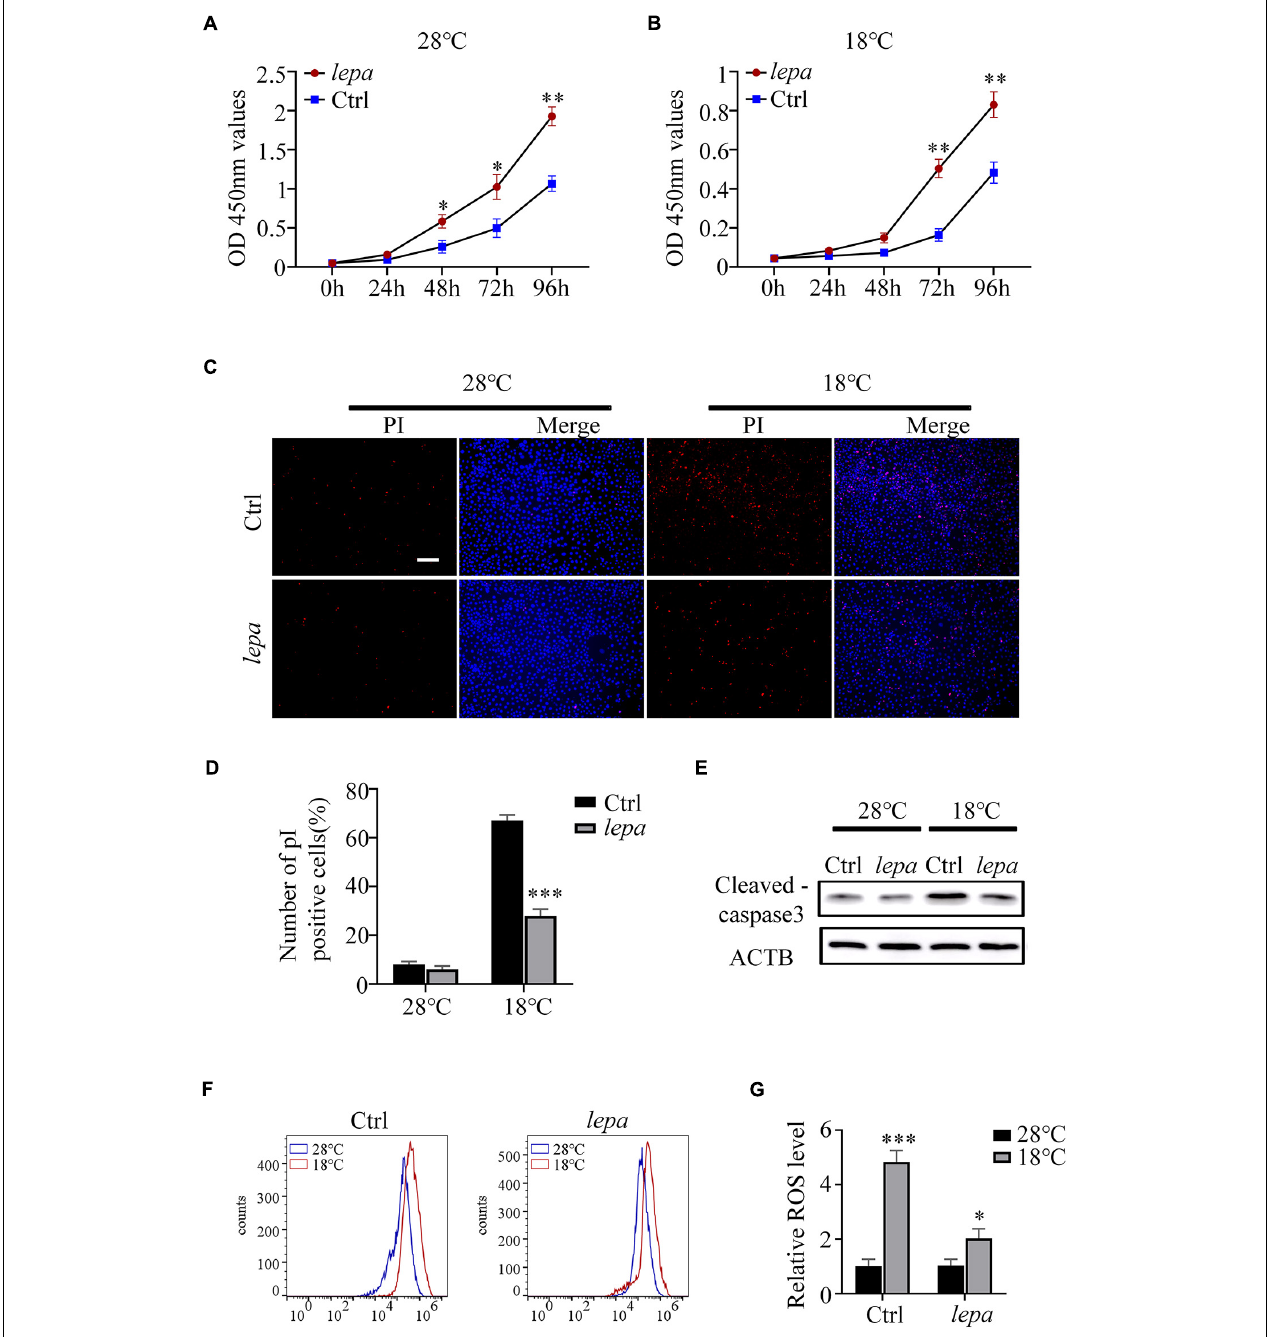
FIGURE 5 | The effect of overexpression of DM-lepa on cells. (A,B) Cell proliferation was determined by assay of CCK8. (C) Apoptosis was evaluated with Hoechst/PI staining. PI stains dead cells or late-stage apoptotic cells with a red fluorescence, and Hochest stain the nuclei with a bright-blue fluorescence. (D) The percentage of apoptotic cells was determined using ImageJ software. (E) Protein levels of cleaved-caspase 3 within cells was detected by western blot analysis. β -actin as the loading control. (F) ROS was detected by flow cytometry and analyzed using FlowJo software. (G) The relative expression of ROS Data were analyzed and graphed using GraphPad Prism 8. The results are presented as mean ± SD ( n = 3), ∗ P < 0.05, ∗∗ P < 0.01, ∗∗∗ P <